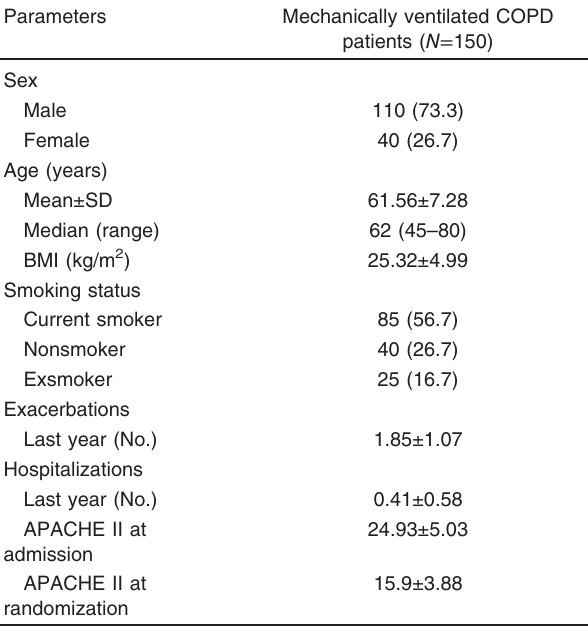
Table 1 Demographic data and patient characteristics (150 mechanically ventilated chronic obstructive pulmonary disease patients)